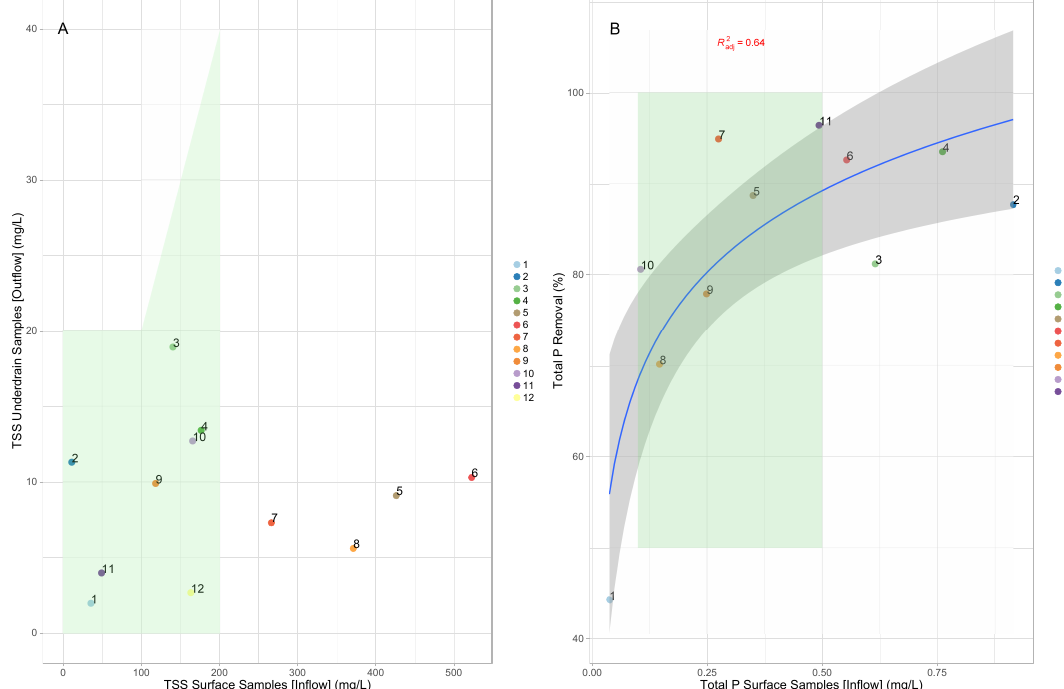
Figure 10. Effluent sample concentrations for TSS ( A ) and removal efficiencies for total P ( B ) at the under drain, versus mean IA surface concentrations (inflow) over storms. Light green regions represent bounding areas that define performance criteria for a stormwater BMP in order to meet the primary (TSS) and phosphorous treatment performance goals in the State of Washington. Storm events are represented by numbered